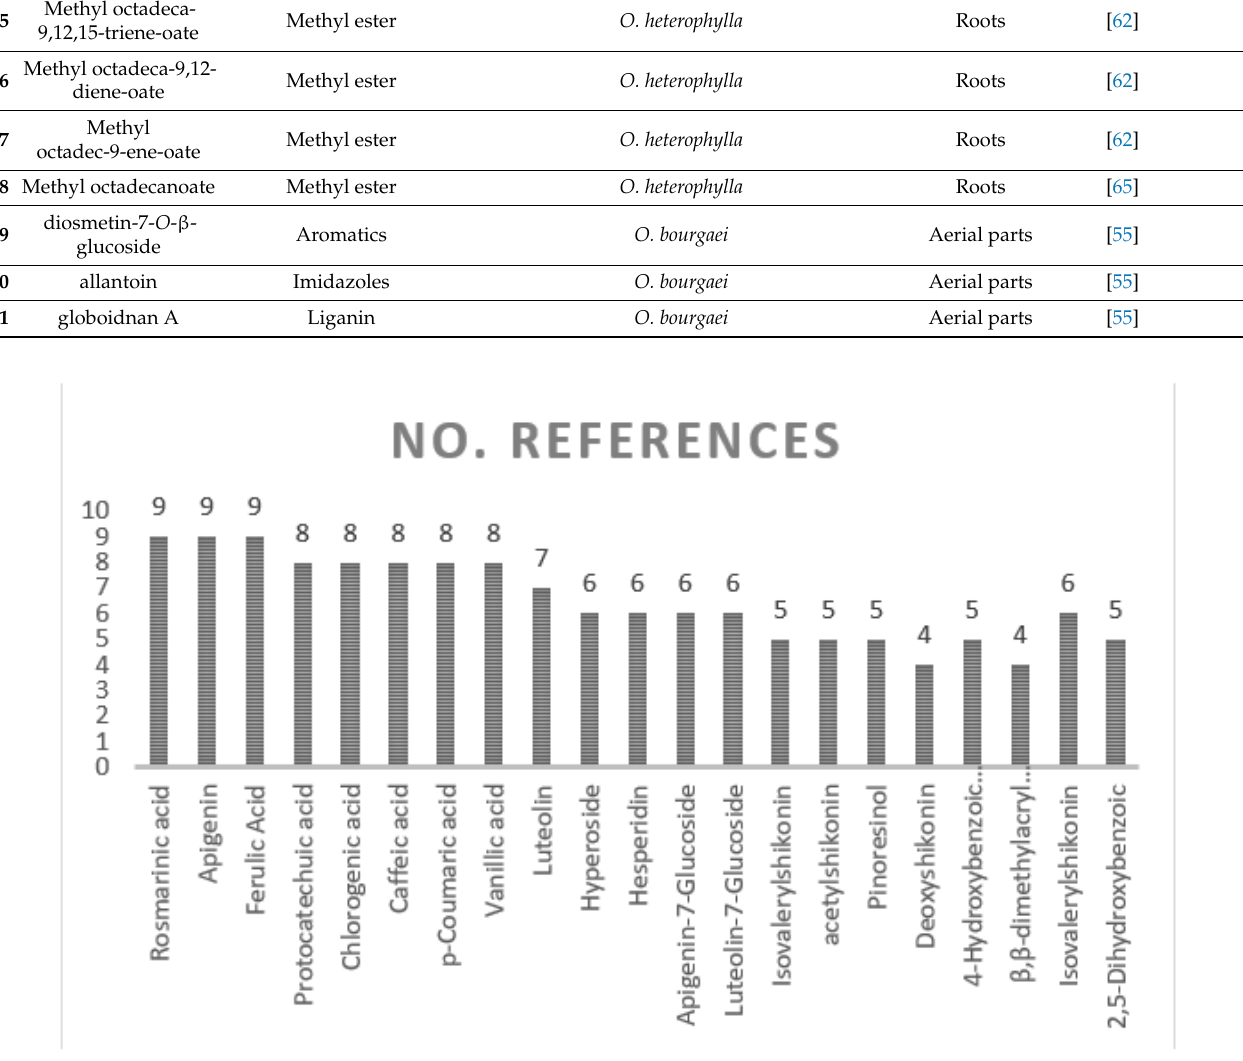
Figure 5. Most common Onosma compounds based on the repetition in the literature. The bioactive structures of identified and characterized representative compounds, which are based on the repetition across published studies are shown in Figure 5, in addition to Figure